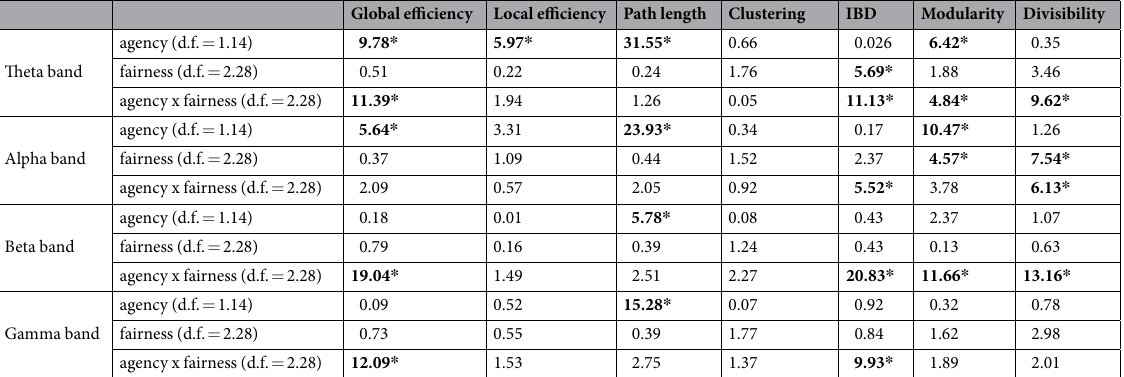
Table 1. ANOVA on indices derived from multiple-brain networks. Results of repeated measures ANOVA computed on the considered graph indices in the four frequency bands. F-values are reported. Significant values (p < 0.05, FDR adjusted) are in bold and highlighted by an asterisk.